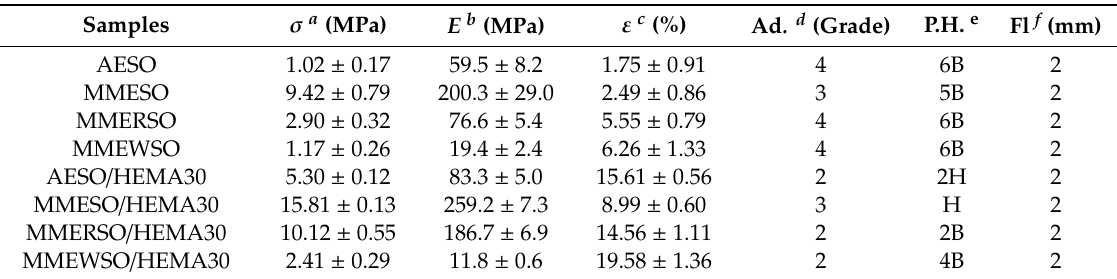
Figure 5. Stress–strain curves of the UV-cured EA-like materials. Table 4. Mechanical properties and coating performance of the UV-cured EA-like